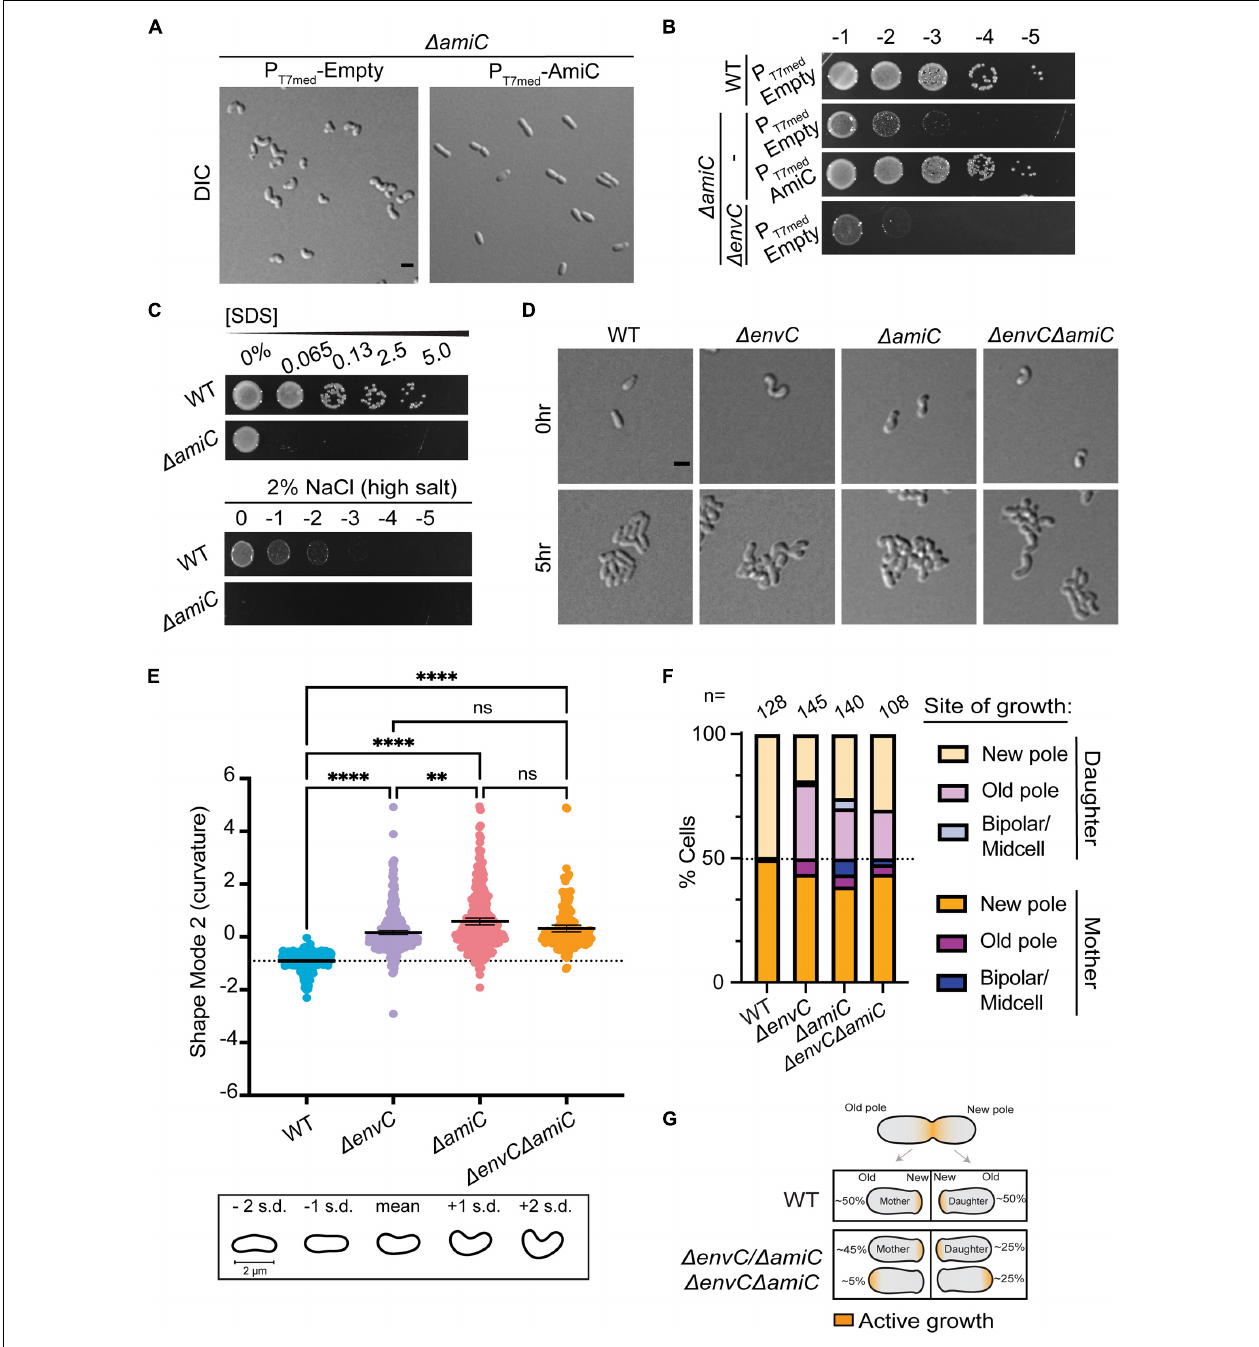
FIGURE 4 | EnvC likely functions in the same pathway as AmiC to help dictate proper polar patterning in A. tumefaciens . (A) DIC images of exponentially growing WT cells containing empty plasmid (PT7med-Empty), (cid:49) amiC containing empty plasmid (PT7med-Empty), or (cid:49) amiC constitutively expressing amiC via the T7 medium promoter [PT7med-AmiC (complementing plasmid)]. Scale bar = 2 µ m. (B) Cell viability of WT cells containing empty plasmid (PT7med-Empty), (cid:49) amiC containing empty plasmid (PT7med-Empty), or (cid:49) amiC constitutively expressing amiC via the T7 medium promoter [PT7med-AmiC (complementing plasmid)] is shown by spotting serial dilutions. (C) SDS and salt sensitivity of WT and (cid:49) amiC as described in Figure 3 . (D) Cell morphology and microcolony formation are shown for WT, (cid:49) envC , (cid:49) amiC , and (cid:49) envC (cid:49) amiC at 0 and 5 h. Scale bar = 2 µ m. (E) Scatter plot depicting shape mode 2 (curvature) from PCA of cell shape for WT, (cid:49) envC , (cid:49) amiC , and (cid:49) envC (cid:49) amiC . (F) Quantification of sites of growth initiation following cell division events captured during time-lapse imaging in WT, (cid:49) envC , (cid:49) amiC , and (cid:49) envC (cid:49) amiC . Daughter cells are defined as cells that inherit the former growth pole. (G) Schematic representation of cell growth polarity inheritance. In WT cells, most mother and daughter cells resume polar elongation at the new pole after completing cell division. However, in the absence of envC , amiC , or both, about 50% of the daughter cells initiate polar growth at the old pole. All data collected for this figure was obtained from cells grown in LB. ** P < 0.01; **** P < 0.0001; ns, not signficant.